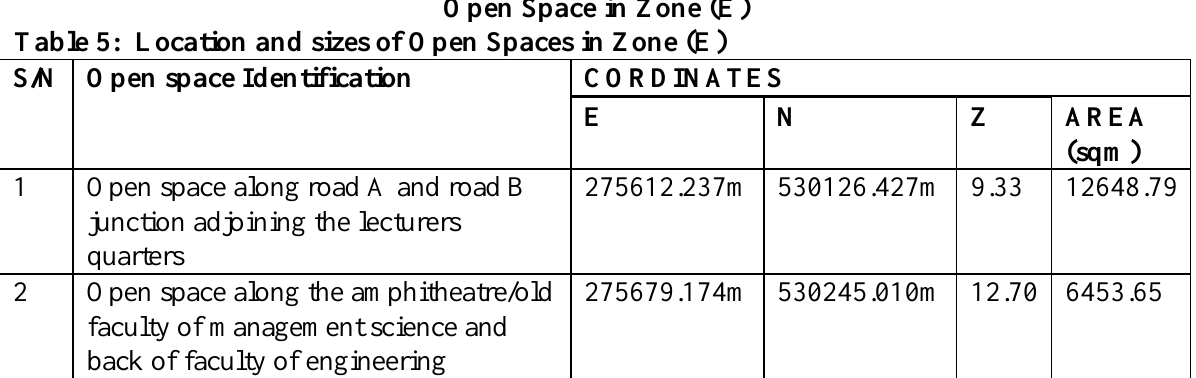
Table 4: Location and sizes of Open Spaces in Zone (D) In zone D, Open space in front of S.U.G secretariat and love garden is the largest vacant space within the zone with a total area of 6543.87sqm.